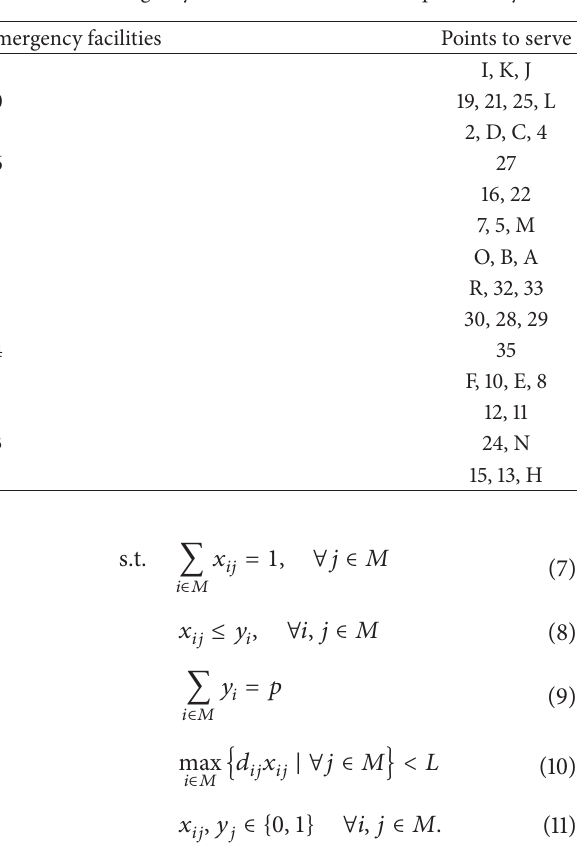
Table 6: The emergency facilities and the demand points they